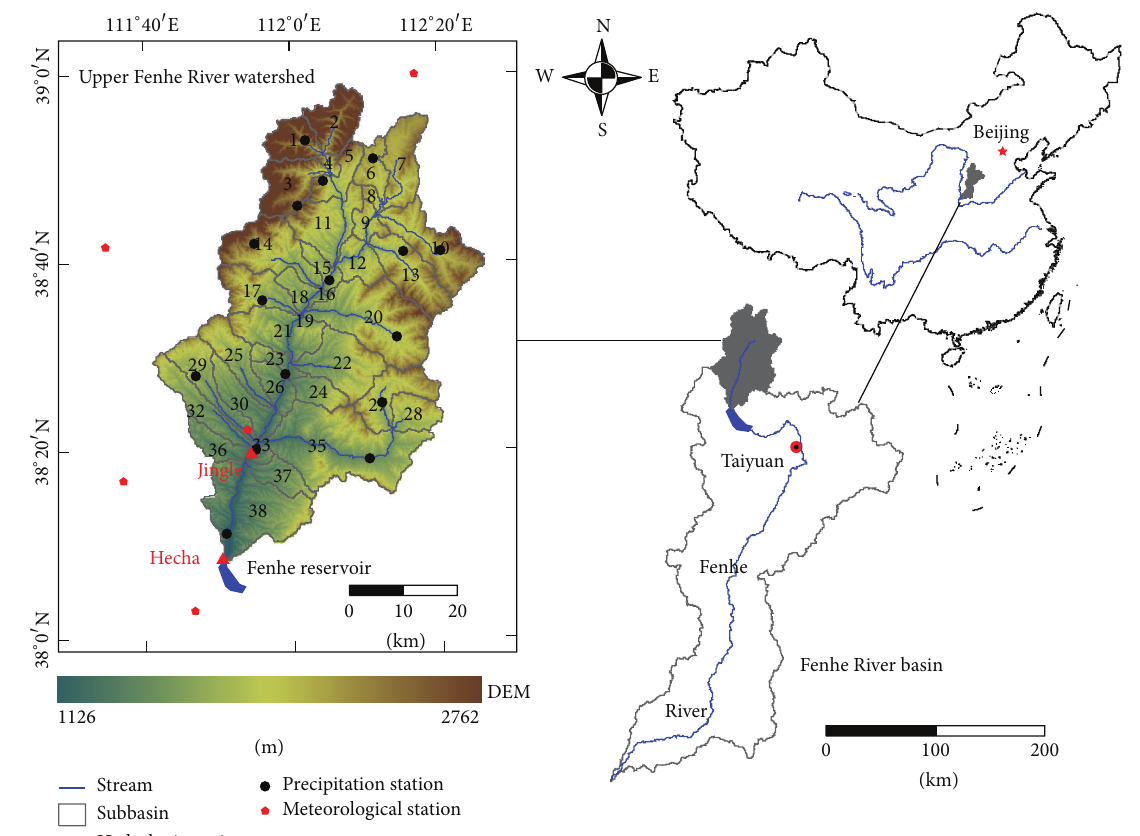
Figure 1: Locations of study area, hydrologic stations, and meteorological stations.